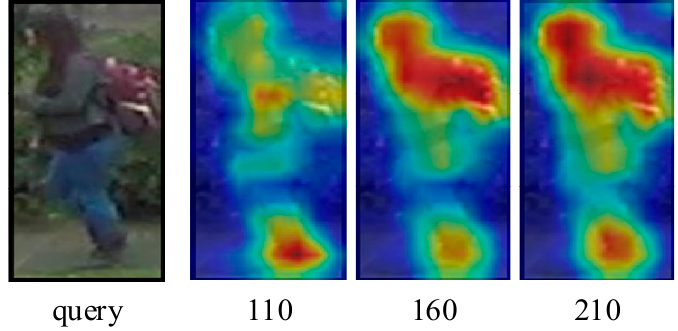
Figure 10. Evolution of the activation maps at different epochs.